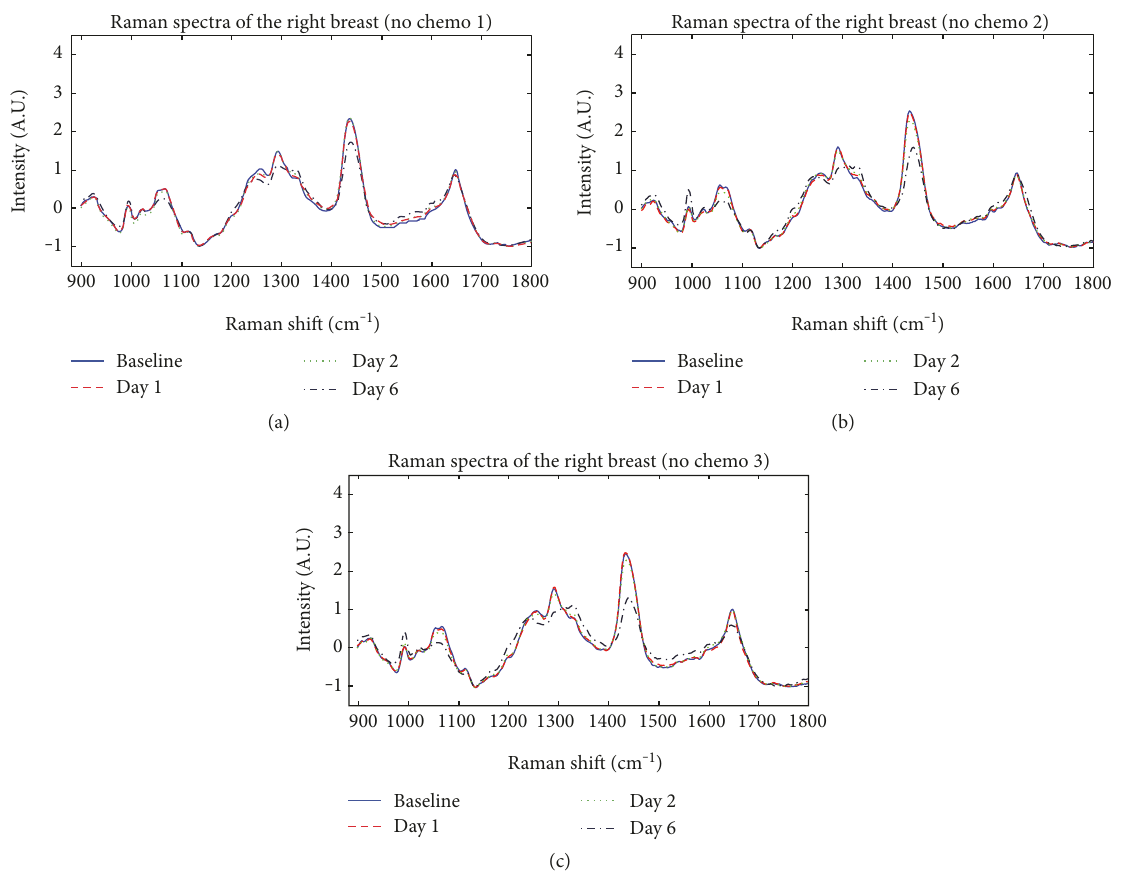
Figure 7: Variation of Raman spectra with breast tumor growth and without breast cancer treatment (no chemo group, baseline means the day high-dose chemotherapy was started). Day n means n day